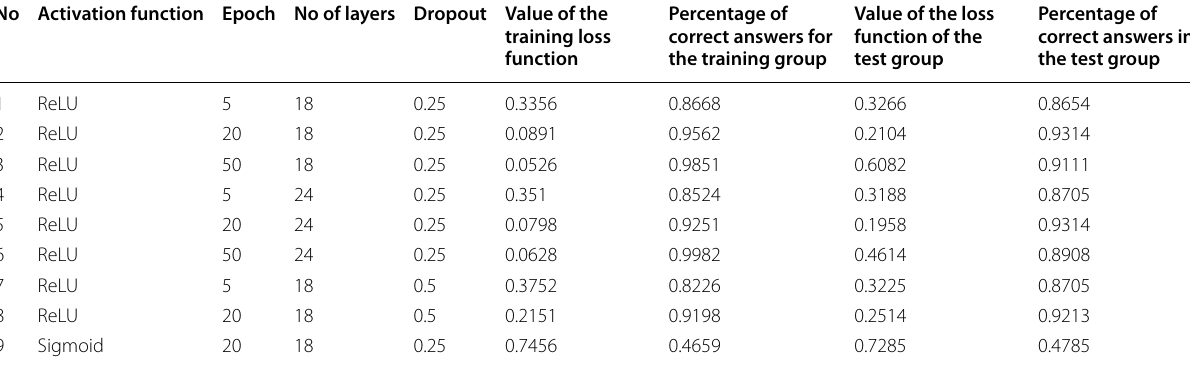
Table 1 Results of the sliding window method (SWM) No Activation function Epoch No of layers Dropout Value of the